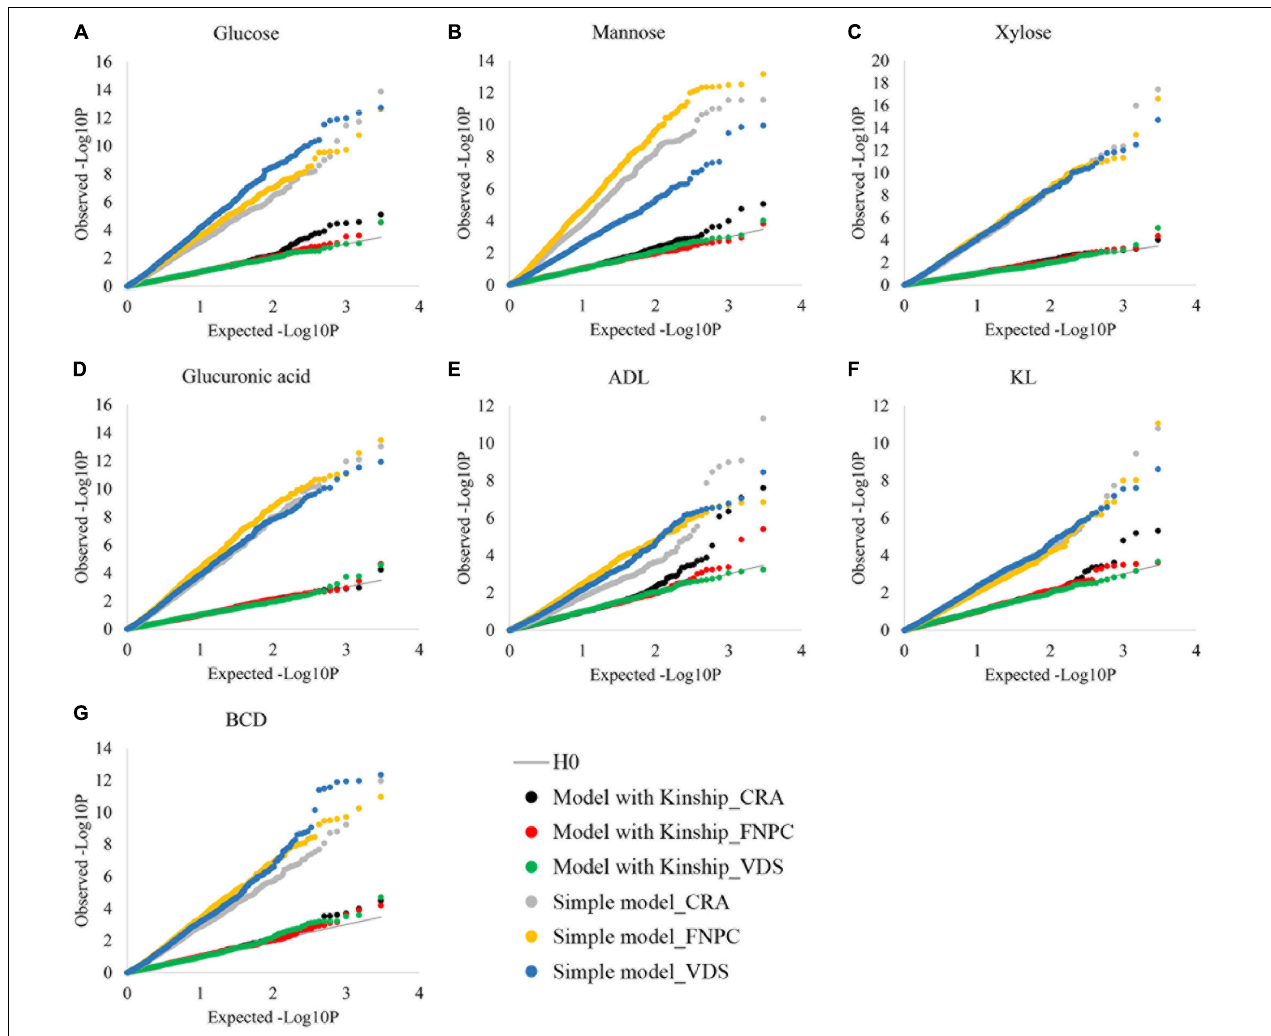
FIGURE 3 | Cumulative distributions of p -values for contents of glucose (A) , mannose (B) , xylose (C) , glucuronic acid (D) , acid detergent lignin (ADL; E) , Klason lignin (KL ; F) and Bast fiber content after decortication (BCD ; G) to assess the correction for population structure. X -axes = the cumulative distributions of the expected-log 10 P for the simple and the kinship models; Y -axes = the cumulative distributions of the observed-log 10 P for the simple and the kinship models; Simple models = models without correction for population structure {dots in gray [Centro di ricerca cerealicoltura e colture industriale (CRA = Italy)], yellow [Fédération Nationale des Producteurs de Chanvre (FNPC) = France], and blue [Vandinter Semo BV (VDS) = The Netherlands]}; Kinship models = models with correction for population structure [dots in black (CRA = Italy), red (FNPC = France), and green (VDS = The Netherlands)]; H0 = models under the expectation that random single nucleotide polymorphism (SNP) markers are unlinked to the polymorphism controlling the traits (gray